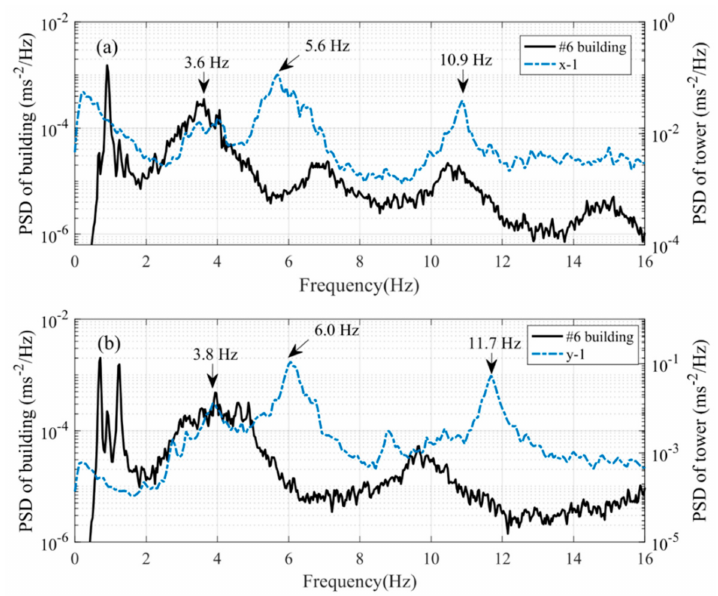
Figure 14. Comparison of acceleration PSDs measured from the roof of the #6 building and the VAWT: ( a ) X-direction; ( b ) Y-direction.